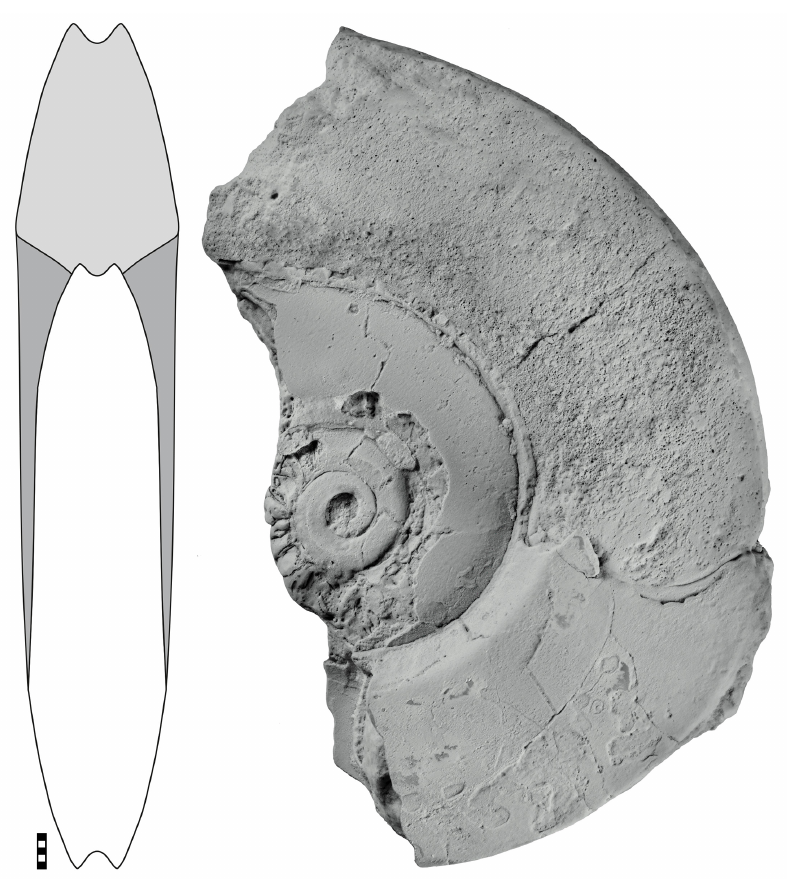
Fig. 25. Aphelaeceras azzelmattiense sp. nov., holotype MB.C.30479.1 (Wendt & Kaufmann 1995 Coll.) from Azzel Matti. Scale bar units = 1 mm.